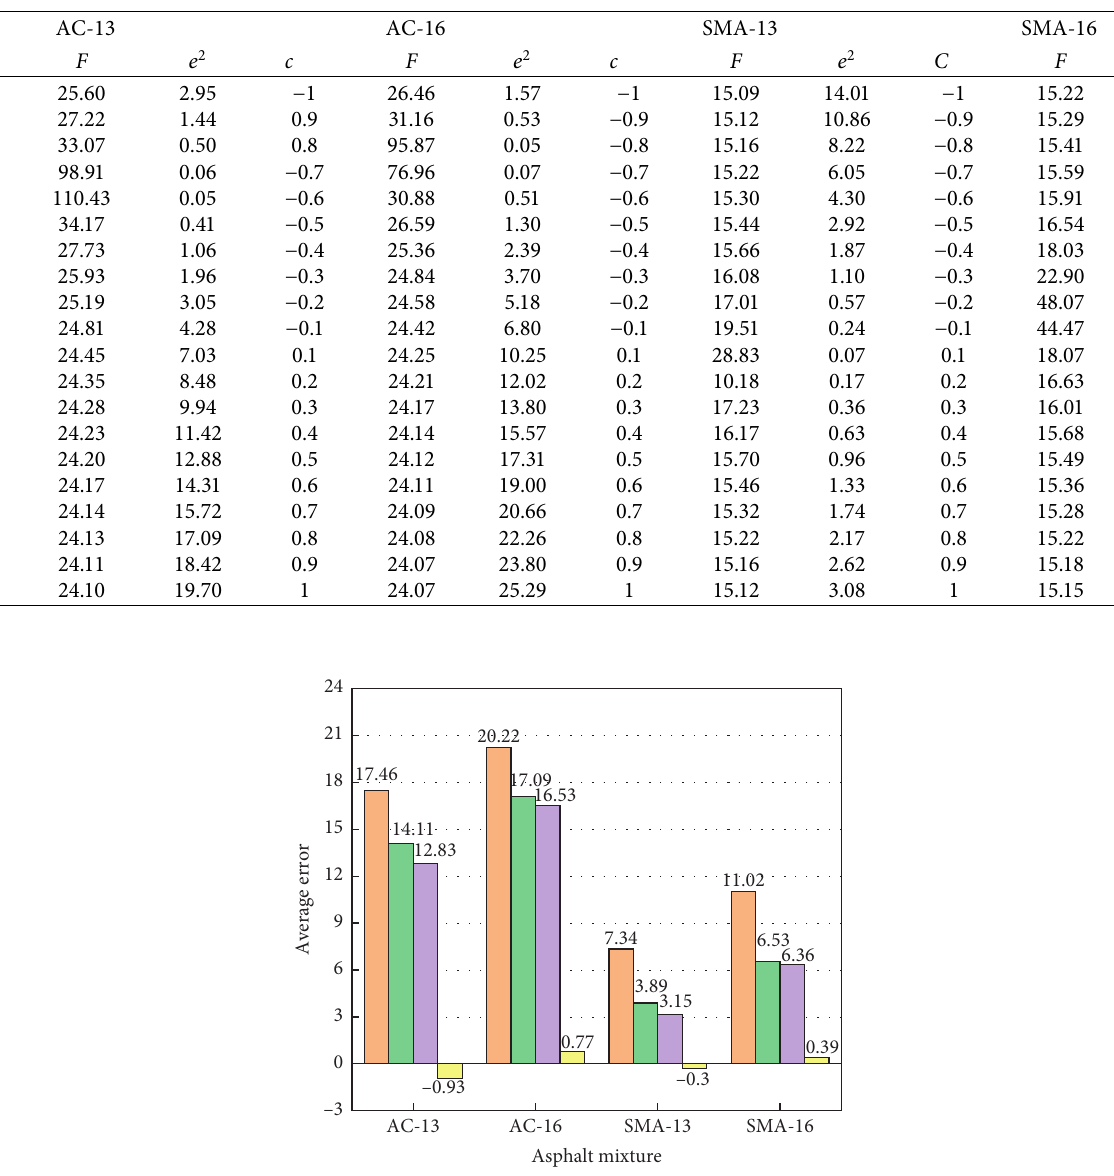
Table 3: Linear regression statistical data of four asphalt concrete types.